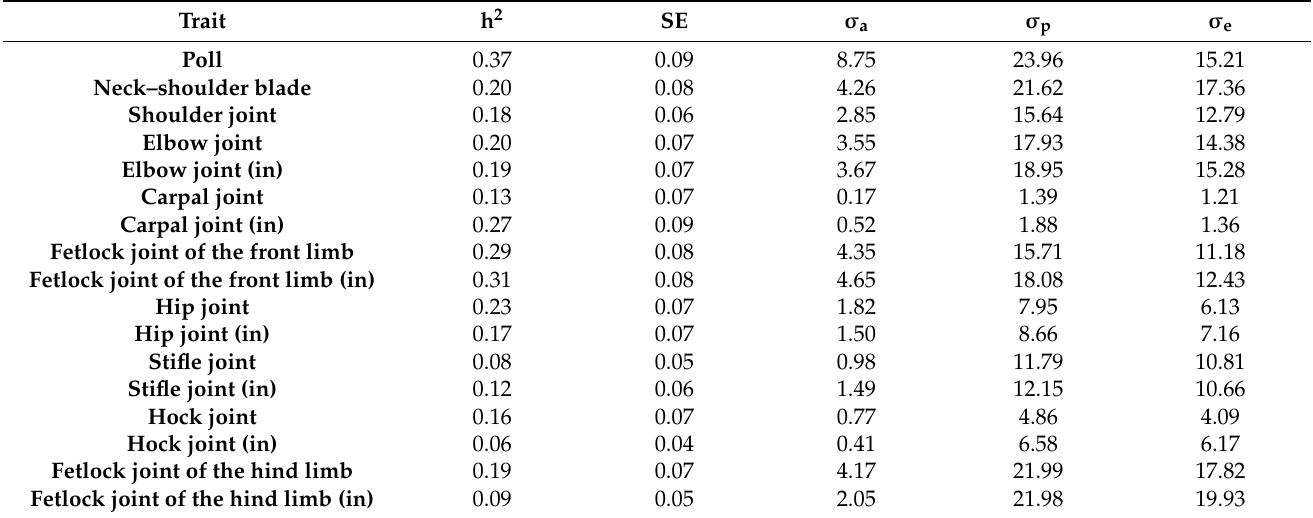
Table 5. Heritability with corresponding standard errors, additive genetic ( σ a ), phenotypic ( σ p ) and residual ( σ e )